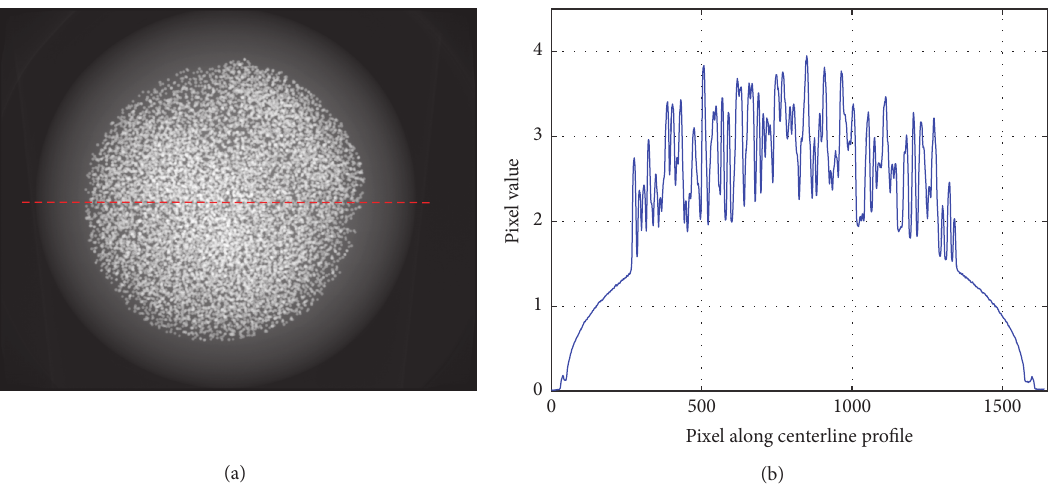
Figure 3: (a) DR of a fuel pebble and (b) its centerline profile marked in (a).